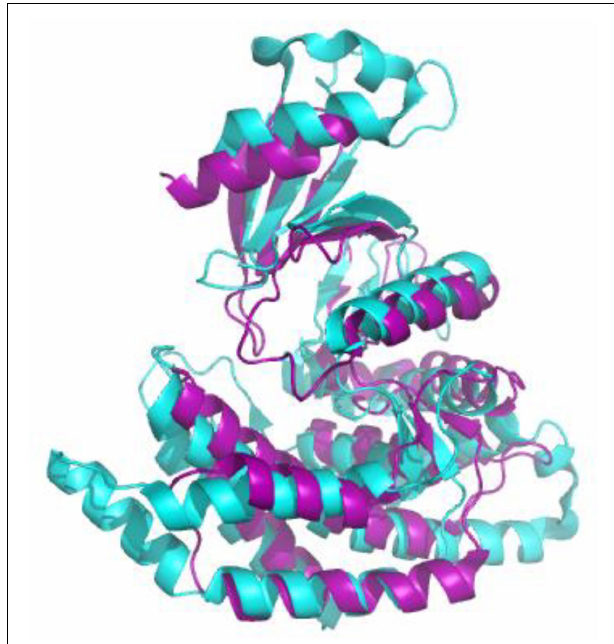
FIGURE 2 | Alignment of the crystal structures of sChoK (purple. RCSB accession 4R77) and hChok (cyan, RCSB accession #2CKO). The basic N-terminal and C-terminal domains are shown to be generally conserved. Alignment and figure generation carried out with the PyMol